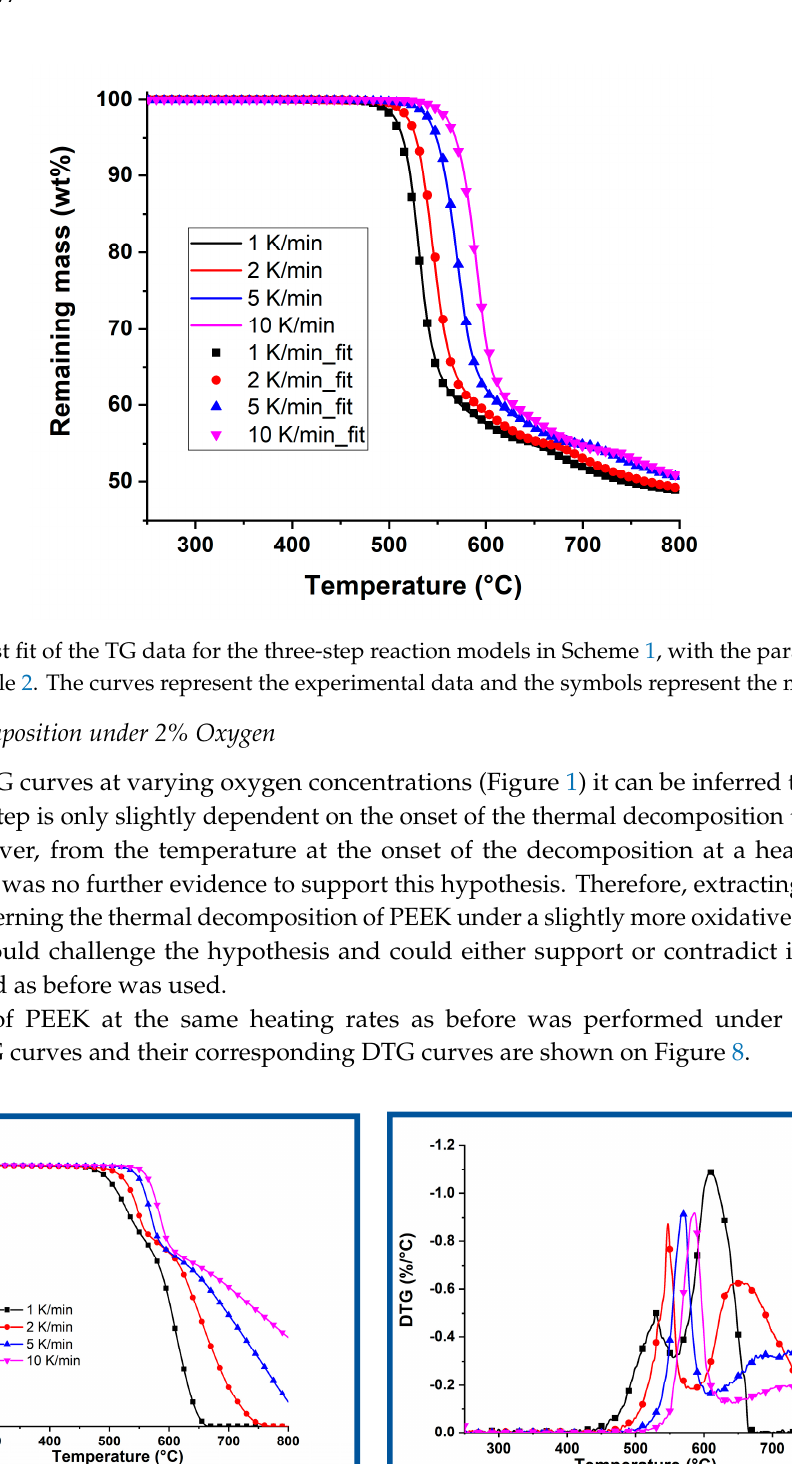
Figure 7. Best fit of the TG data for the three-step reaction models in Scheme 1, with the parameters given on Table 2. The curves represent the experimental data and the symbols represent the model.